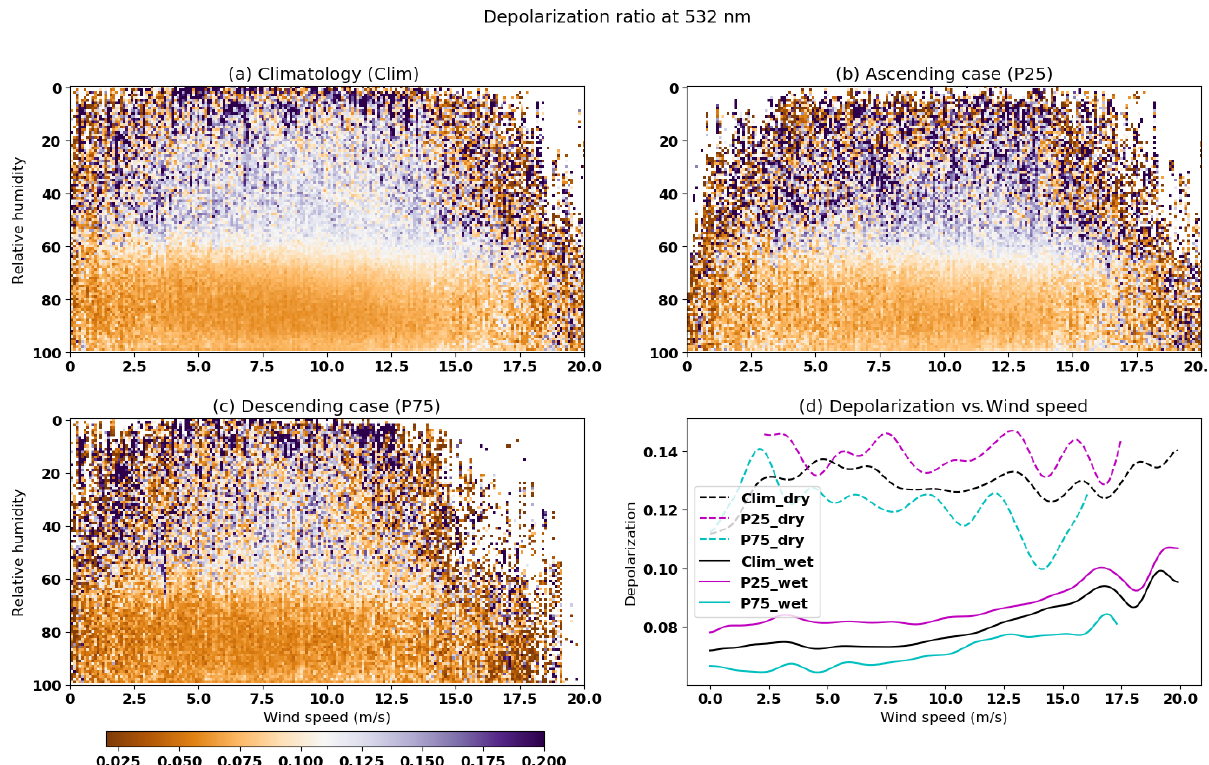
Figure 3. The same as in Fig. 1 but for the particulate depolarization ratio (532nm). In panel (d) depolarization is further classified into two categories based on the relative humidity, namely dry (RH < 60%) shown as dashed lines and wet (RH > 60%), shown as solid lines and is expressed as a function of surface wind